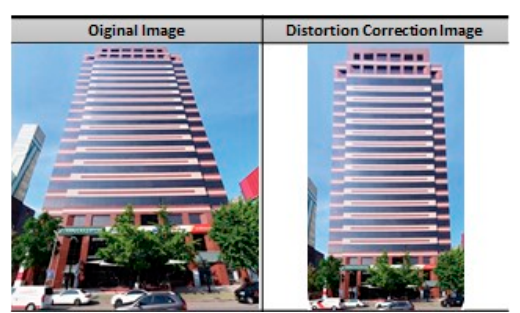
Figure 7. Distortion correction [10,20].